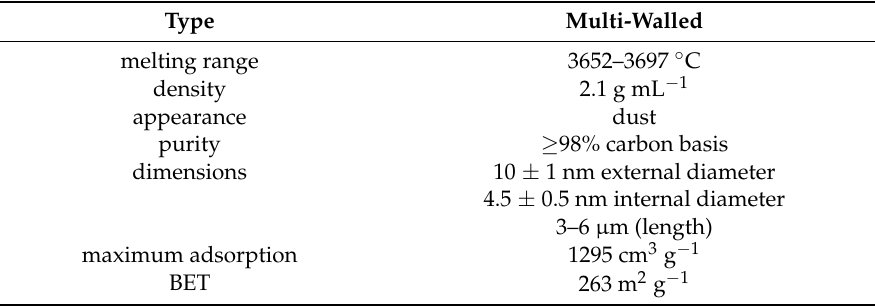
Table 1. Characteristics of the multi-walled carbon